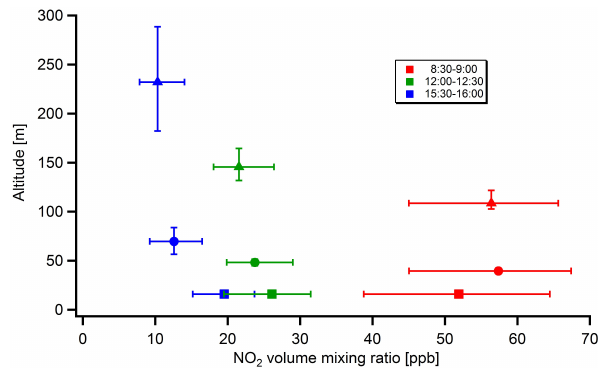
Fig. 10. NO 2 volume mixing ratio altitude profiles derived from LP- DOAS and MAX-DOAS 1 ◦ and 3 ◦ elevation angle values at a time period between 08:30 and 09:00 (red), 12 and 12:30 (green), and 15:30 and 16:00. (blue) in south